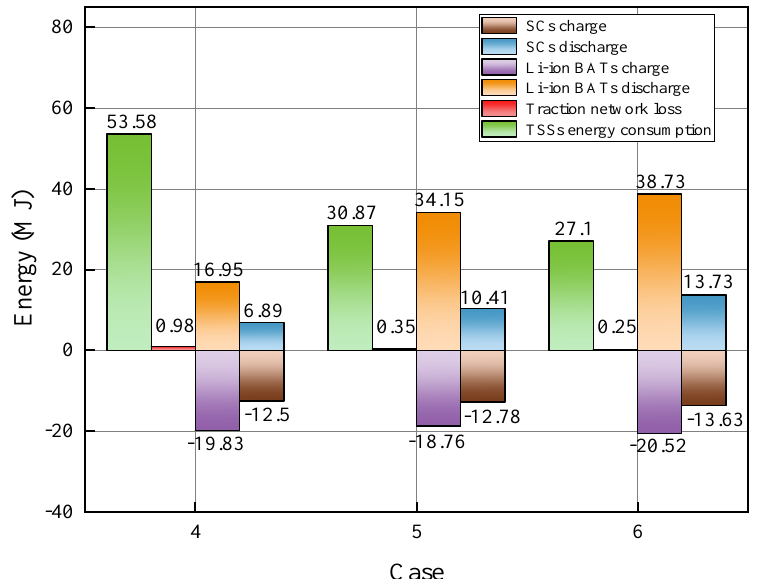
Figure 12. The energy flow of all the components in cases 4–6.